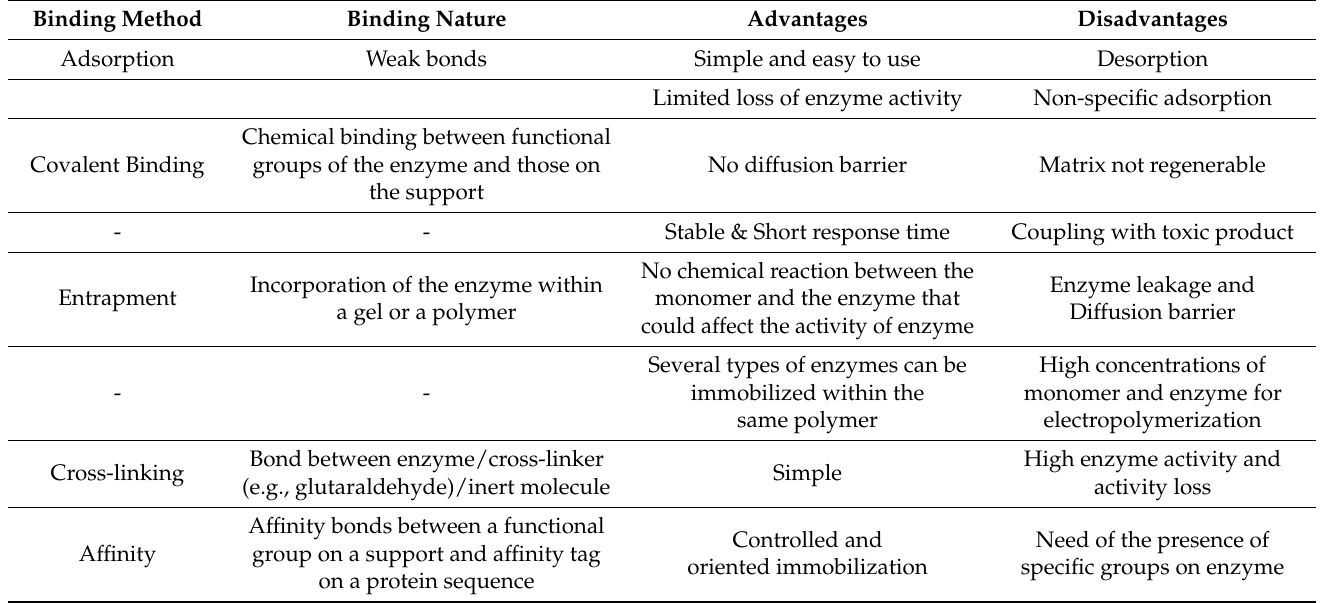
Table 3. Advantages and disadvantages of biocatalysts immobilized on porous supports. Binding Method